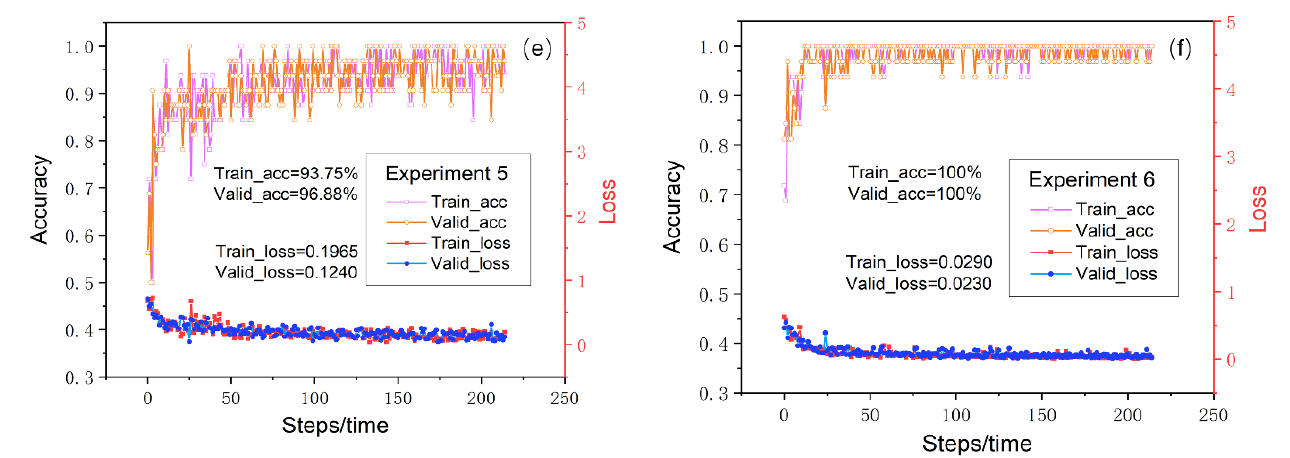
Figure 14. The accuracy and loss curves of the six groups of transfer learning models. ( a – f ) respectively shows the training loss, training accuracy, validation accuracy and validation loss of the transfer learning model of the experimental 1–6.